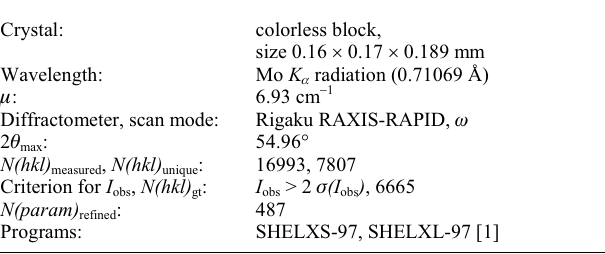
Table 1. Data collection and